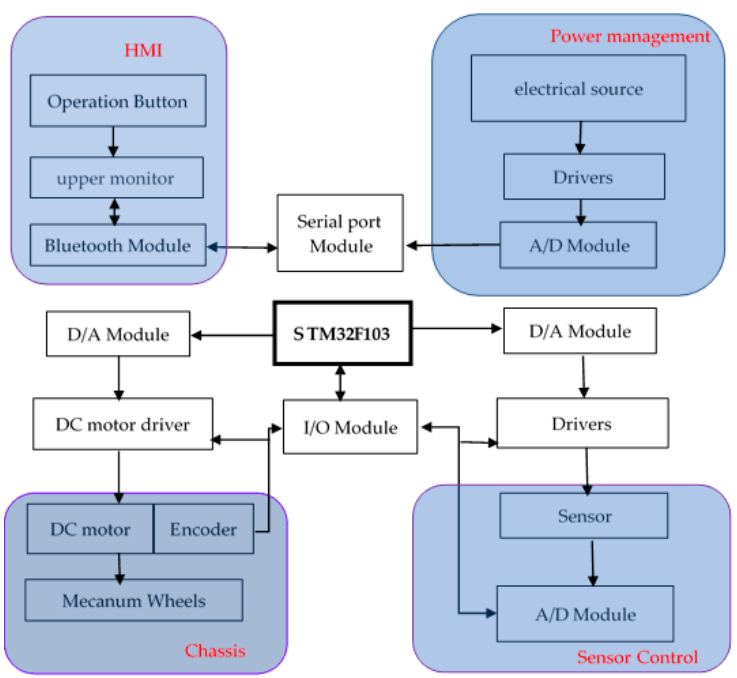
Figure 8. Block diagram of the control system.